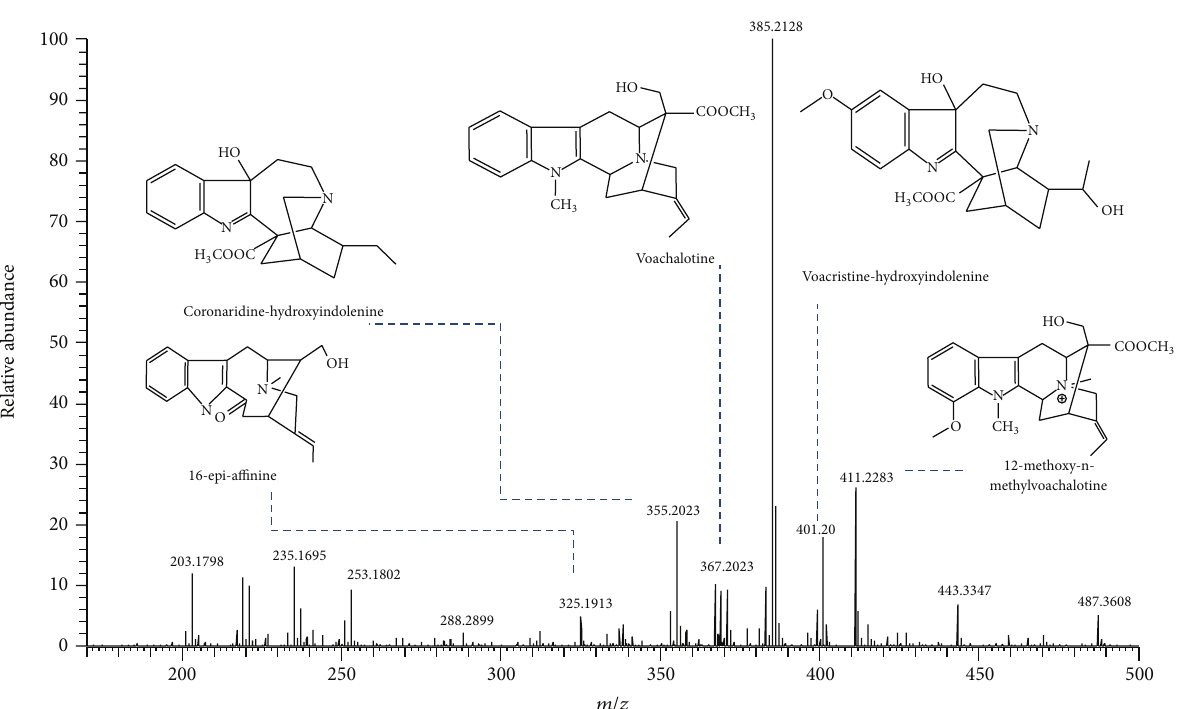
Figure 2: Electrospray positive spectra of T. catharinensis extract and structures of identified alkaloids compounds.